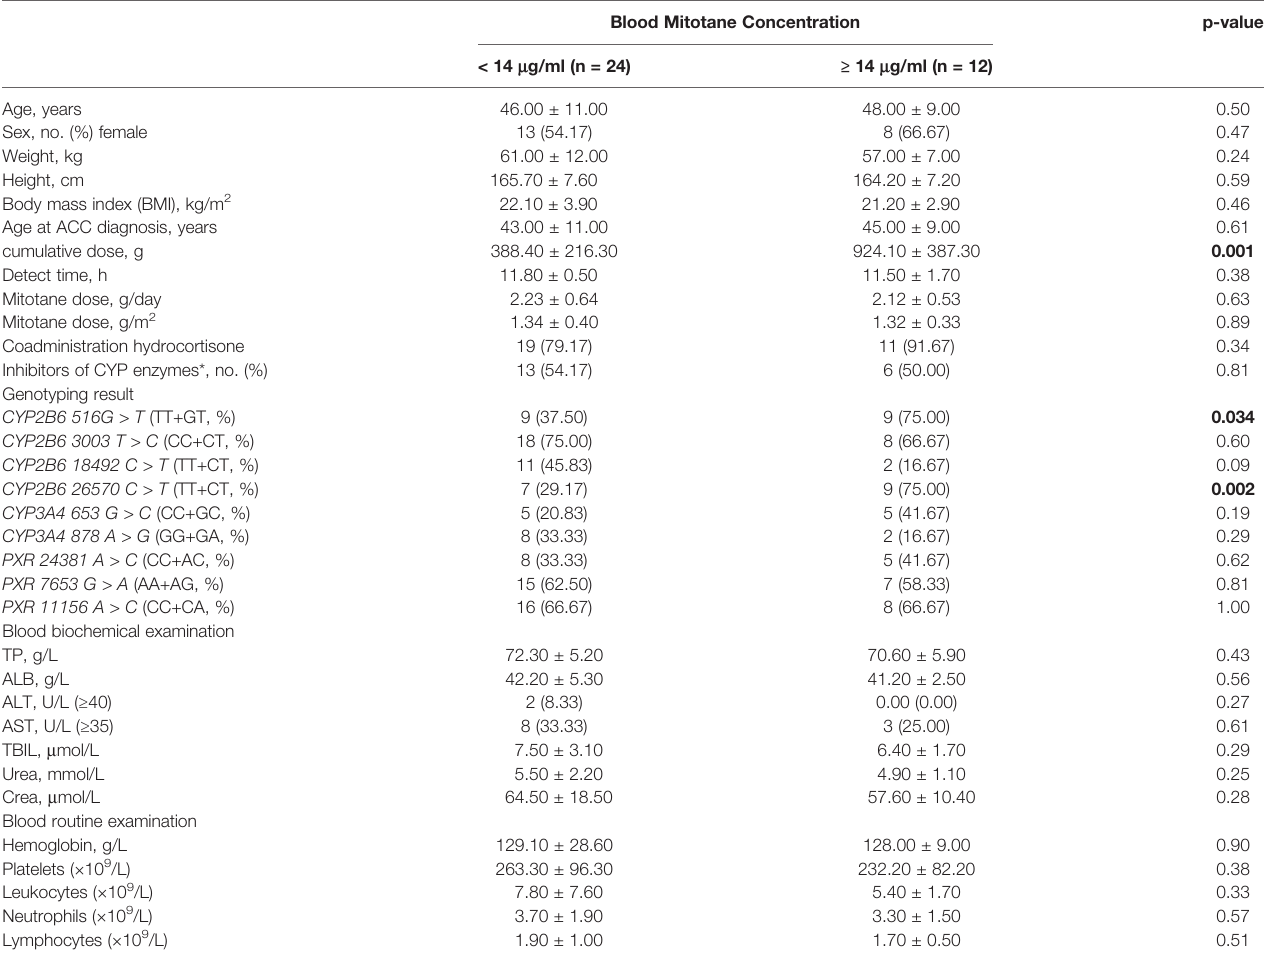
TABLE 2 | Univariate analysis of factors associated with a low concentration of mitotane (<14 m g/ml). Blood Mitotane Concentration p-value